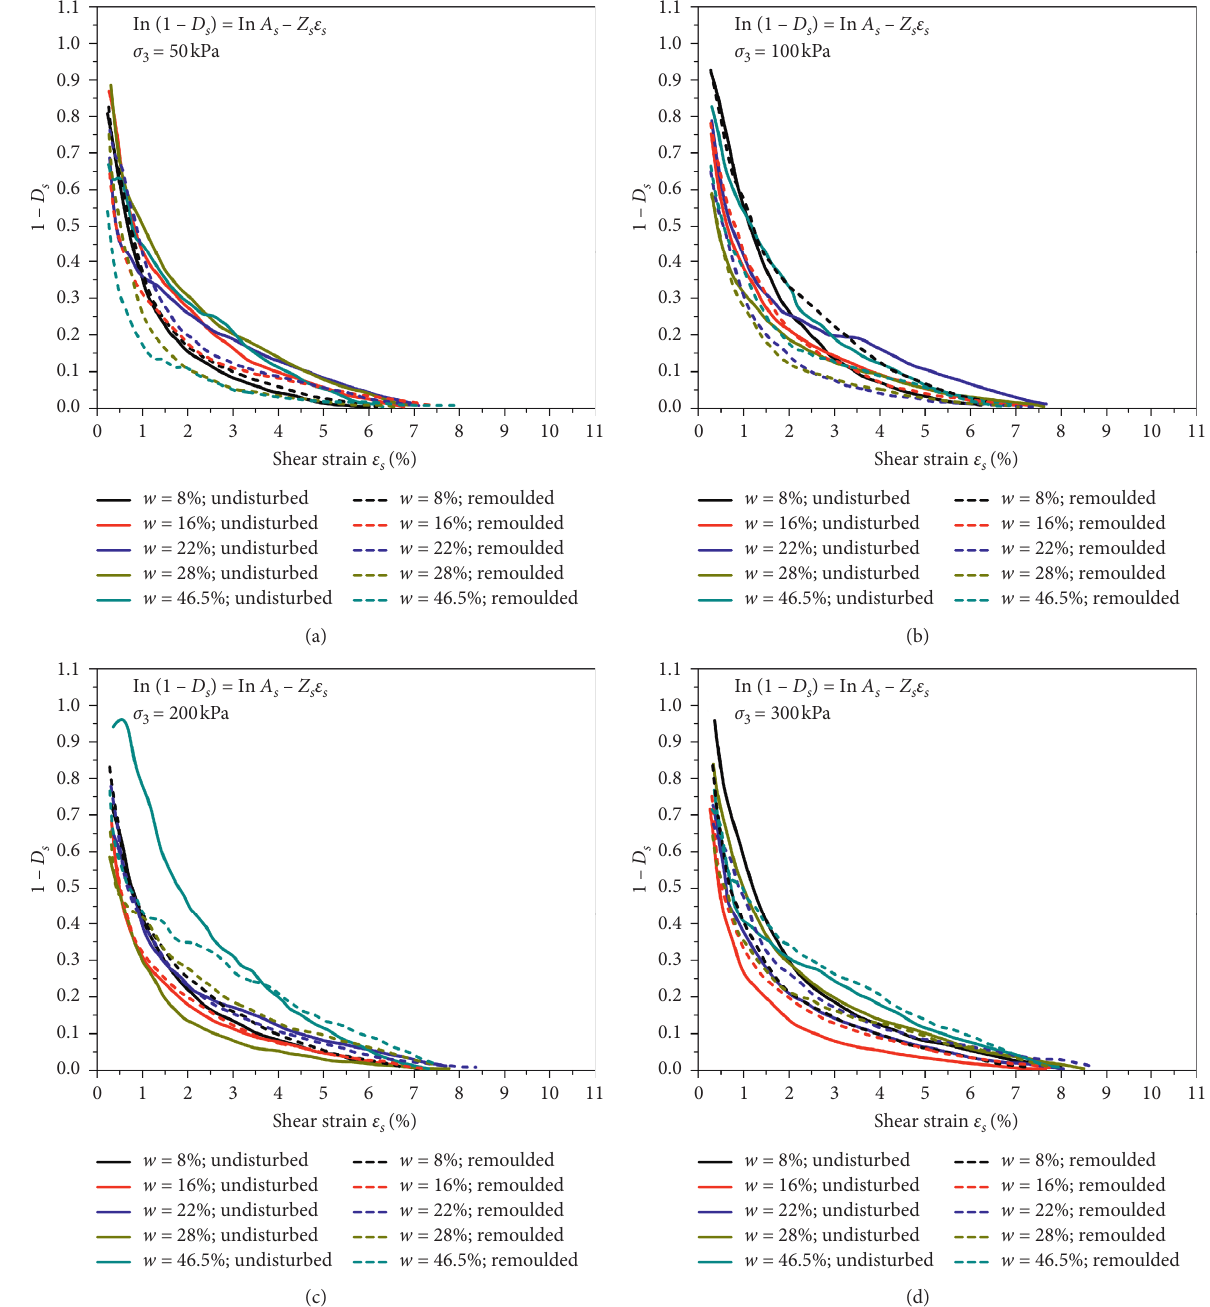
Figure 7: Evolution curves of disturbance functions based on shear strain for undisturbed and remoulded soil samples. (a) σ (b) σ 3 � 100kPa; (c) σ 3 � 200kPa; (d) σ 3 �